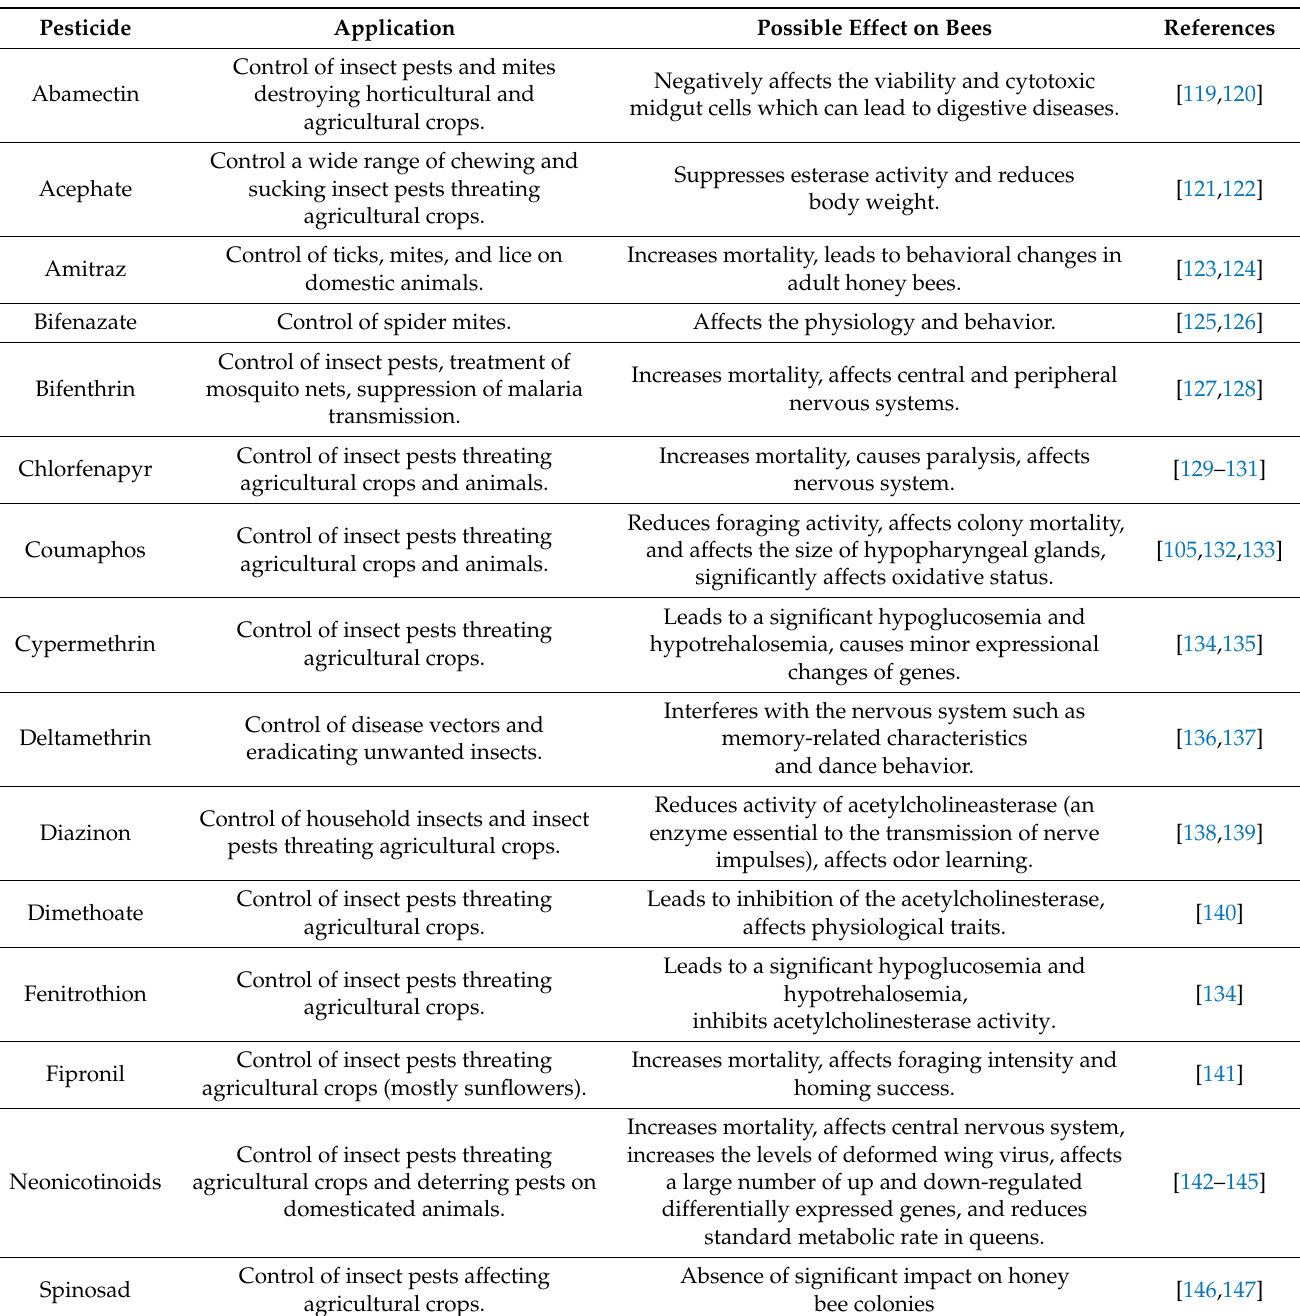
Table 1. Recognized possible effects of chosen pesticides on A. mellifera health (under laboratory